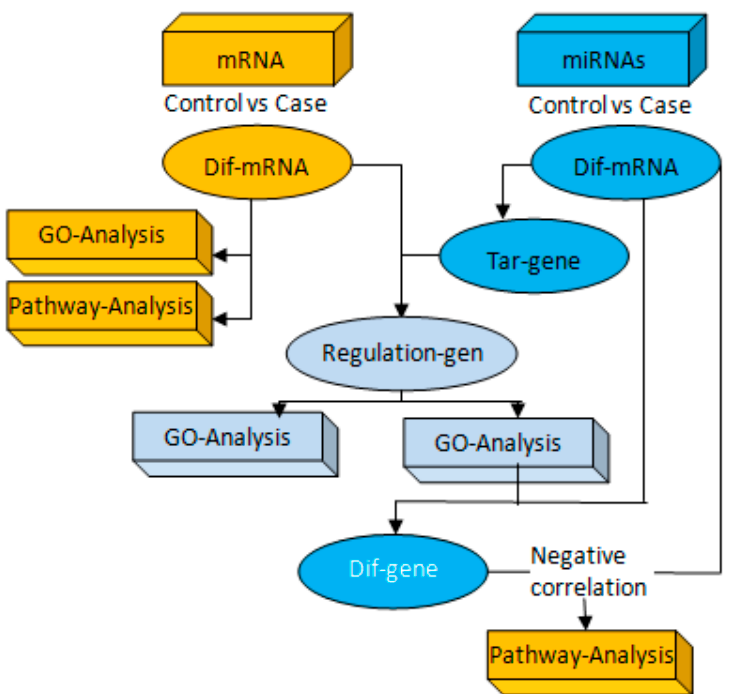
Figure 1. Combined analysis of messenger RNA(mRNA) and microRNAs (miRNAs). Firstly, we set up miRNAs and mRNA sequencing analysis of several groups with the same comparative combination to conduct miRNA–mRNA association analysis. Then, if the transcriptome analysis of the group comparison results in differential genes, and the miRNAs analysis results in differential miRNAs and corresponding target genes, the integration analysis of miRNAs and mRNA could be performed for the group comparison.